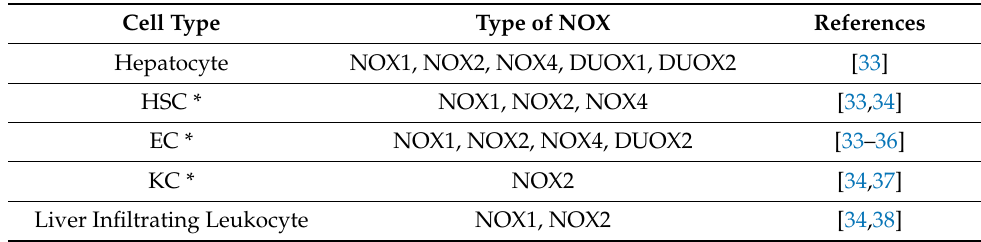
Figure 1. Schematic illustration of the molecular organization of NOX isoforms and their associated subunits. The catalytic core of NOXs is formed by six transmembrane domains (here shown simplified). Figure was created with BioRender.com (accessed on 19 July 2021). Table 1. Cellular distribution of NOXs in the liver.